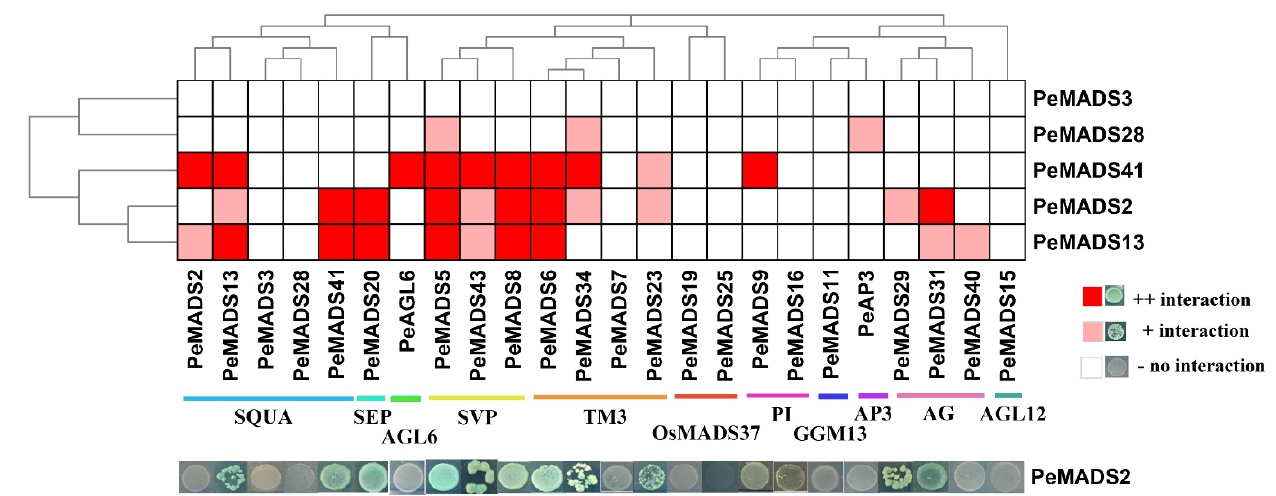
Figure 3. Protein–protein interactions (PPI) among PeSQUAs and PeMADSs. A yeast two-hybrid assay was performed to verify the interaction among PeSQUAs and other MADS-box proteins. The result was displayed by the phylogenetic tree of the bamboo MADS-box gene family. The dark red represents a strong reaction, light red represents a mild reaction, and gray represents no reaction.